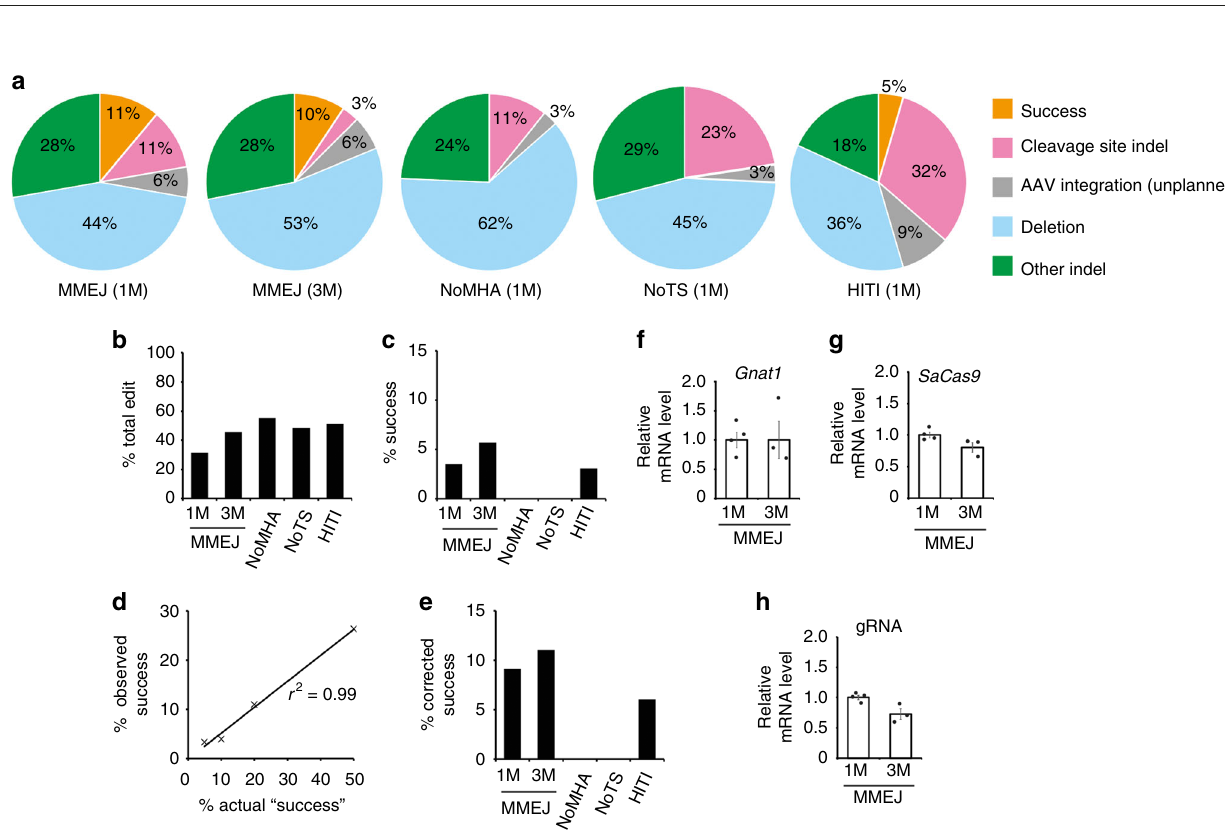
Fig. 1 In vivo characterization of mutation replacement genome editing. a Illustration of MMEJ-mediated mutation replacement. Genome of interest (GOI) with and without the mutation are excised at the fl anking gRNA target sites (gRNA-T1 and -T2; dotted line) from mouse genome and AAV vector, respectively, by SaCas9 and two gRNAs. GOI without mutation is inserted into the genome using microhomology arms (MHA), thereby correcting the mutation. b GNAT1 staining. GNAT1-positive photoreceptors (arrowhead) were observed (section, left; fl atmount, right). c Co-localization of Kusabira Orange (mKO1, red) probing SaCas9 expression and GNAT immunopositivity (inset, green). Scattered GNAT-positive cells were observed only in the area transduced with mKO1 (section, top; fl atmount, bottom). Note, oversized reporter vector (5201 bp) drastically reduced editing ef fi ciency. N = 4 d PNA and recoverin staining with quanti fi cation ( N = 4). e RT-PCR of Rho , Pde6b , Rcvrn , and Pkc α (relative to Pde6c cp fl 1/cp fl 1 mice; N = 4 for all). f Rescue ef fi ciency by RT-PCR of Gnat1 (relative to Pde6c cp fl 1/cp fl 1 mice; N = 4 for all). g 6-Hz fl icker ERGs. N = 9, 9, 4, 4, and 4 for No treatment (NoTx), MMEJ, MMEJ + L-AP4, NoMHA, NoTS, respectively. In MMEJ + L-AP4, MMEJ vector and L-AP4 were sequentially injected. Amplitudes ( − 1.0 log.cd.s.m − 2 ) relative to those of Pde6c cp fl 1/cp fl 1 mice indicate %rescue ef fi ciency (bottom right). h . Single fl ash ERGs. The same group of mice used in g . Scale bar: 20 µ m; Data represent mean ± S.E.M.; * P < 0.05 (Student ’ s t -test); ns, not signi fi cant; PAM, protospacer adjacent motif, OHS, over-hanging sequence; Abx, antibodies; NoTS, no gRNA target sites. Source data are provided as a Source Data fi le.